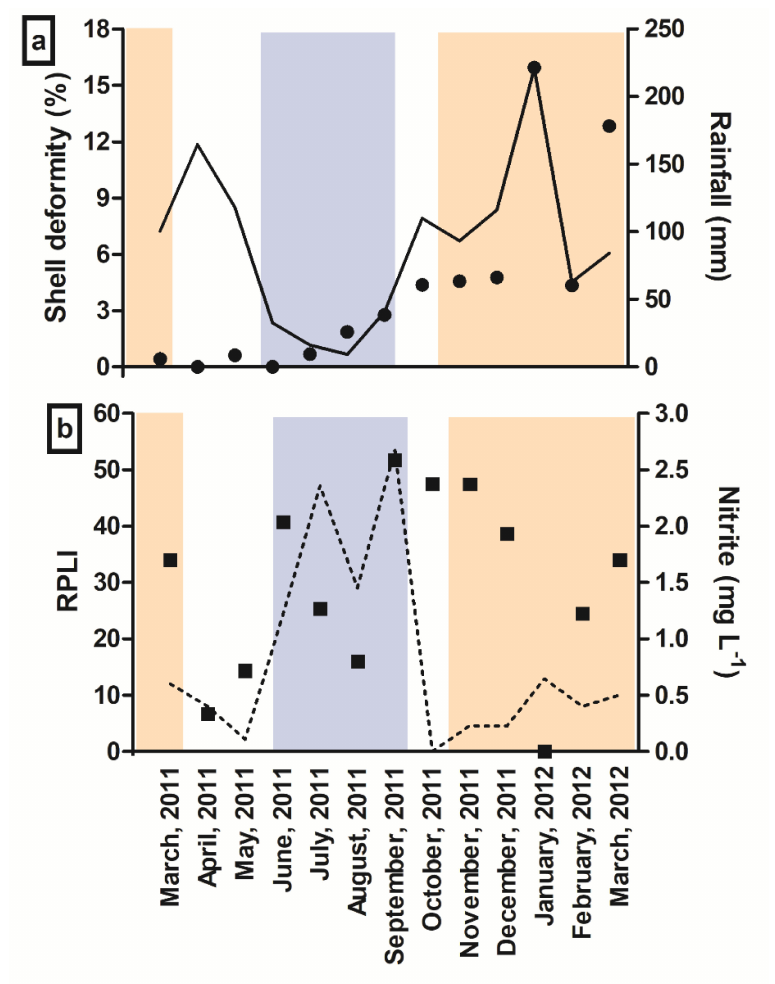
Figure 5. Stress-related population attributes of Heleobia autralis (left Y-axis) differed significantly among seasonal groups (PERMANOVA, p ≤ 0.05) and the environmental variable of higher influence (right Y-axis) by month throughout the study period. ( a ) Incidence of shell deformity (%, • ) and accu- mulated rainfall (mm; full line); ( b ) Relative Penis Length Index (RPLI, (cid:4) ) and nitrite concentration (mg L − 1 ; dotted line). The months corresponding to distinct seasonal groups, as evidenced by PCA of environmental data, are indicated by different colors: warm-rainy (orange), intermediate (white), and cold-dry